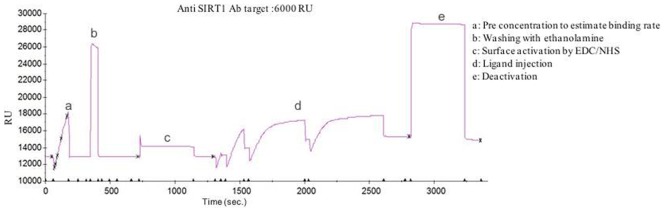
Sensogram showing the immobilization of SIRT1 antibody on CM5 sensor chip.